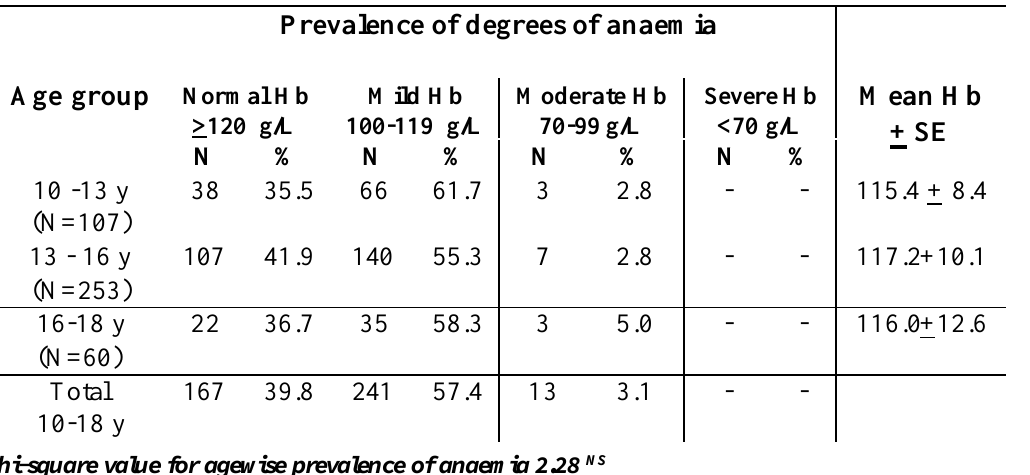
Chi-square value for agewise prevalence of anaemia 2.28 NS F / Ratio for agewise mean haemoglobin 1.29 NS